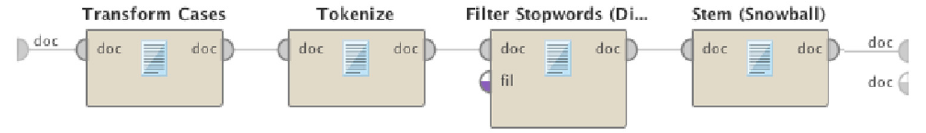
Fig 7. Process document from data operator